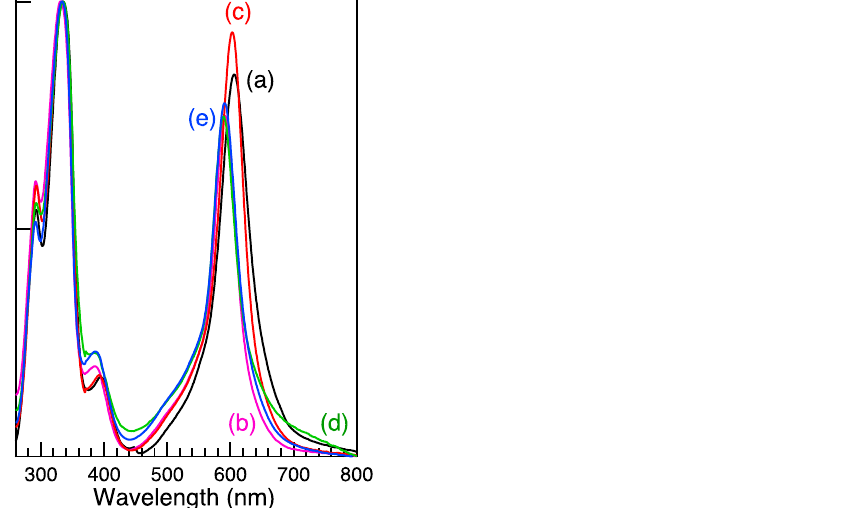
Figure 3. UV-vis spectra for polyFe/LIIm composites ( a ) 3/0.1, ( b ) 3/0.5, ( c ) 3/1, and ( d ) 3/5 and ( e ) reference polyFe films cast on quartz glass. The vertical axis is normalized with absorbance at ~335 nm.